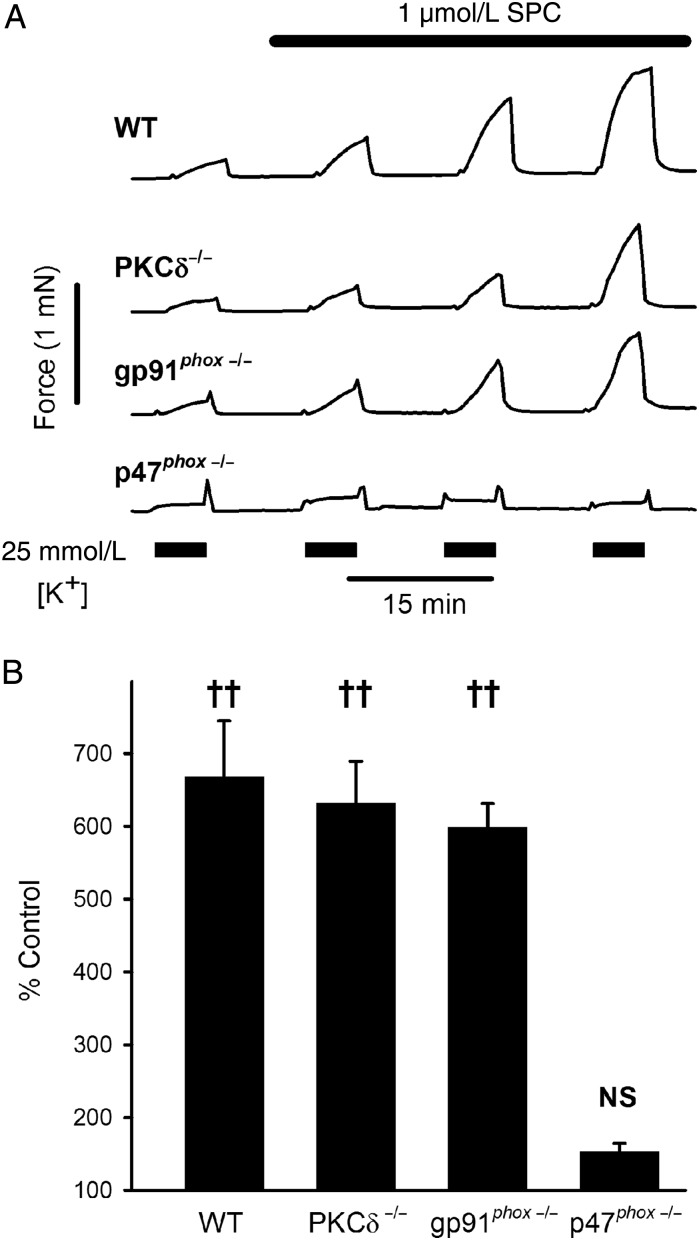
SPC-induced potentiation in MA of mice. We found no difference between MA from C57BL/6 and 129/SV WT mice, so the data were pooled. (A) Typical tension recordings from MA of WT, PKCδ−/−, gp92phox−/− and p47phox−/− mice for 5 min challenges with PSS containing 25 mmol/L [K+] in the presence of 1 µmol/L SPC. (B) Mean data from WT (n = 11, 7 mice), PKCδ−/− (n = 4, 4 mice), gp92phox−/− (n = 6, 4 mice), and p47phox−/− mice (n = 11, 7 mice; challenge 2). Bars = SEM. ††P < 0.001 vs. control; two-way ANOVA, Holm-Sidak post hoc.